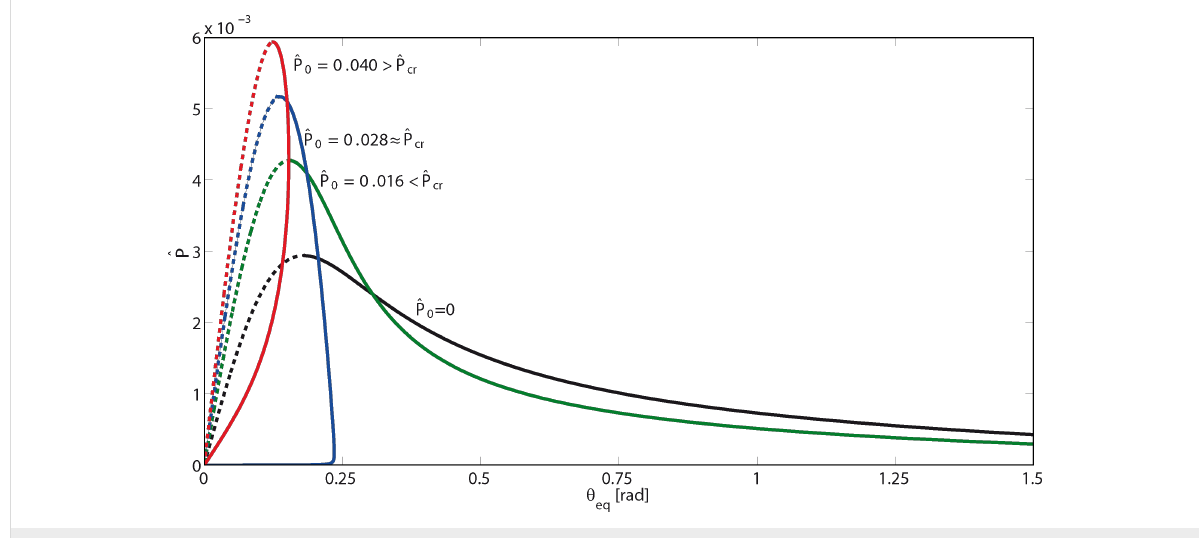
Figure 3: The dimensionless peeling force as a function of the peeling angle θ eq at equilibrium, for different values of the dimensionless pre- tension . The pre-tension generally increases the pull-off force at low peeling angles.